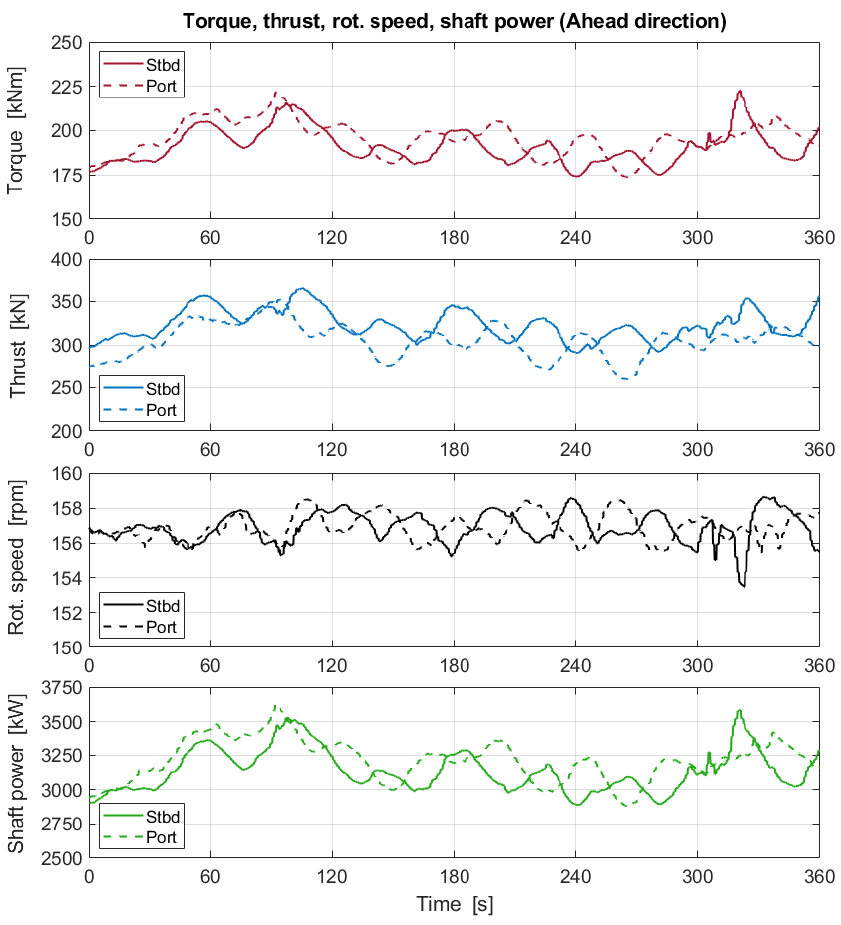
Figure 19. Time series of Q , T , and n during forward-direction ice navigation, on 16 March 2020. The data series of both shafts’ sensors are